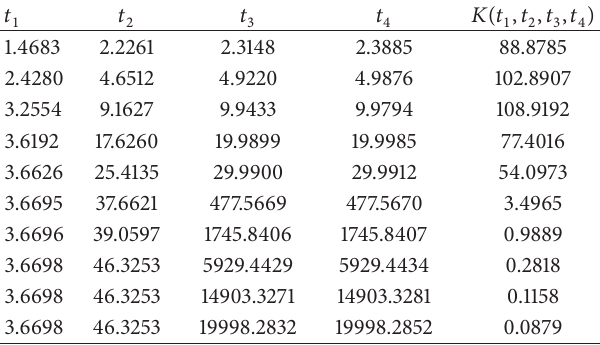
Table 1: The results for average cost of the first cycle for infinite planning